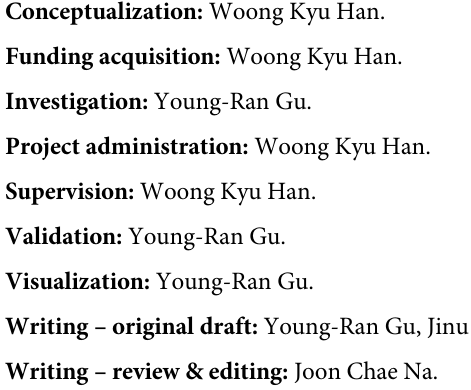
S2 Fig. Normal tubule cells were not affected by SIRT3 overexpression. a. VHL mRNA lev- els were assessed using qRT-PCR after SIRT3 overexpression. Values are expressed as mean ± SEM (n = 3, per triplicate) and control-cell values were set to 1. b. Quantitative analysis of cellular glucose uptake (n = 6, per triplicate) and L-lactate production (n = 3, per triplicate). Values are expressed as mean ± SEM and control-cell values were set to 1. c. Mitochondrial membrane potentials were improved by SIRT3 overexpression. Data are expressed as mean ± SEM (n = 6, per triplicate) and control-cell values were set to 1. � p < 0.05, �� p <